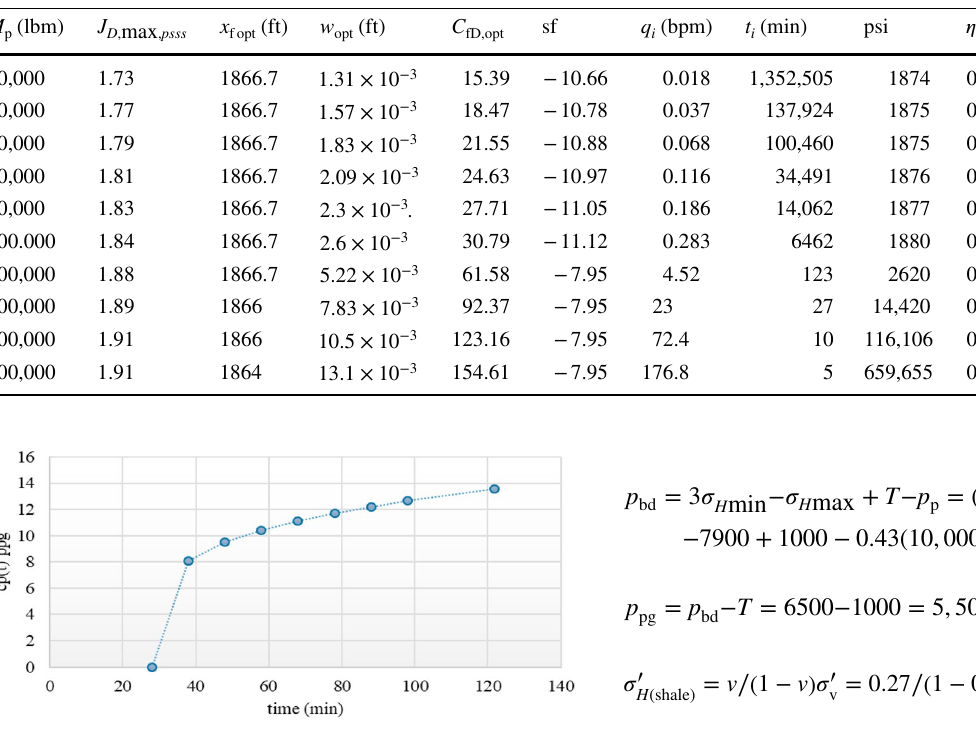
Fig. 8 Proppant schedule